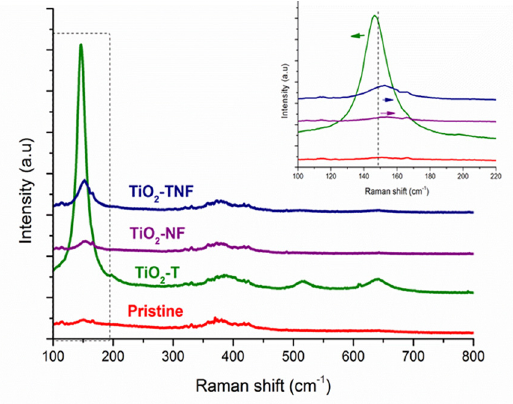
pristine, TiO -T, TiO -NF and 2 2 2